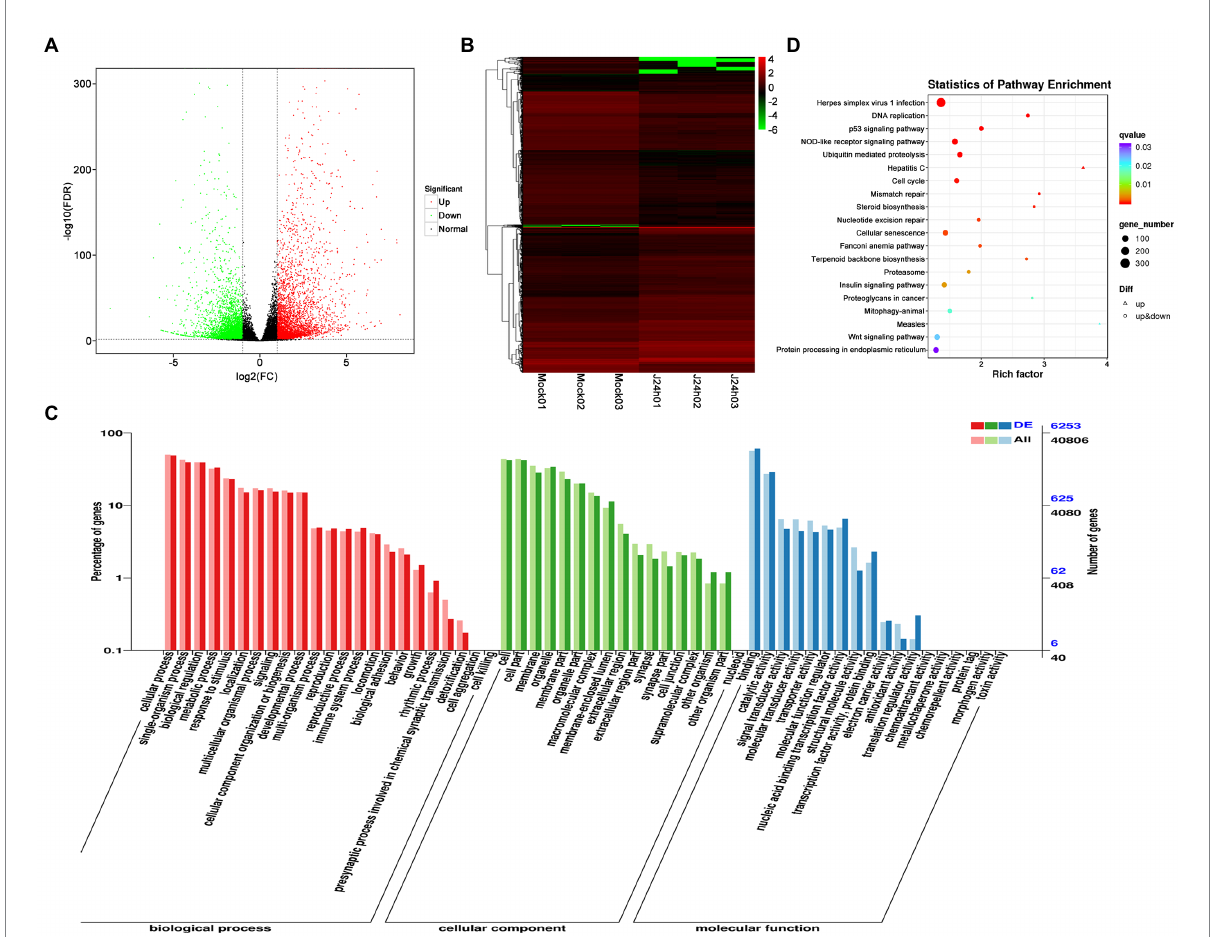
FIGURE 2 Comparison and enrichment analysis of DEGs in the Mock versus J-IHNV infection groups. (A) Volcano plot of DEGs. (B) Hierarchical clustering analysis of DEGs. (C) GO enrichment of DEGs. (D) KEGG enrichment analysis of